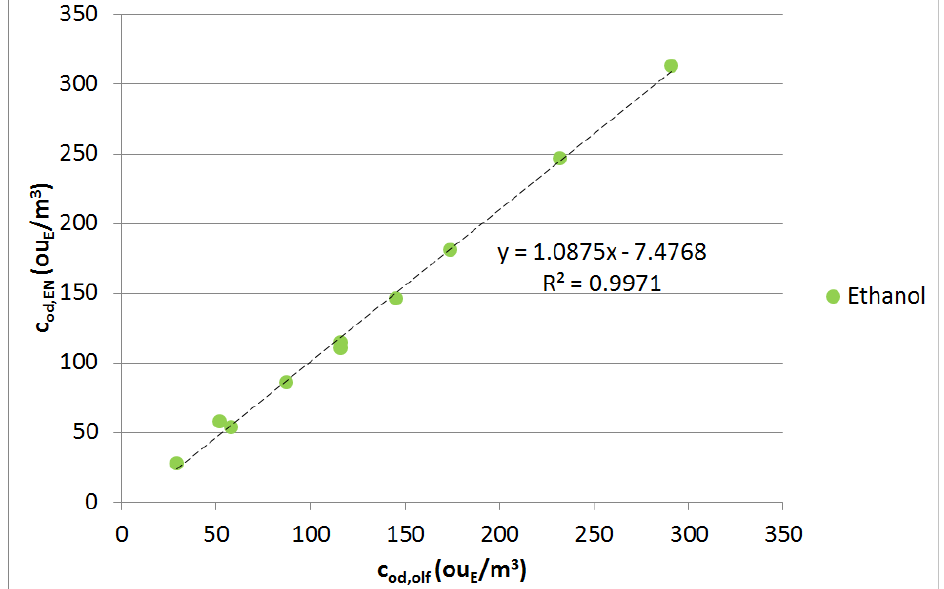
Figure 7. Estimated vs. real odour concentration of the ethanol samples.